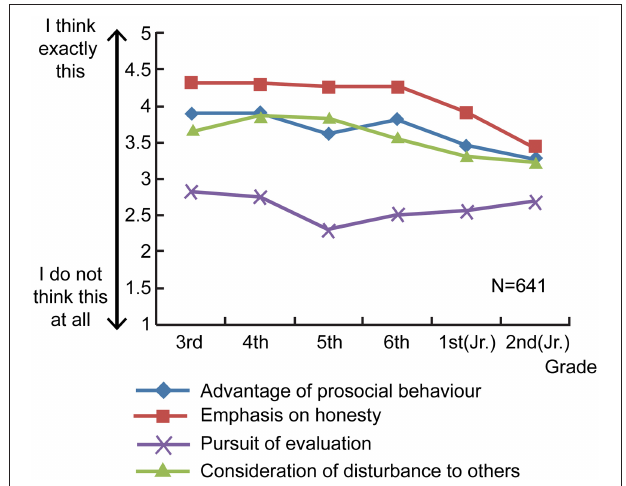
FIGURE 2 | Average admission ratings across each grade level and motive (motives for